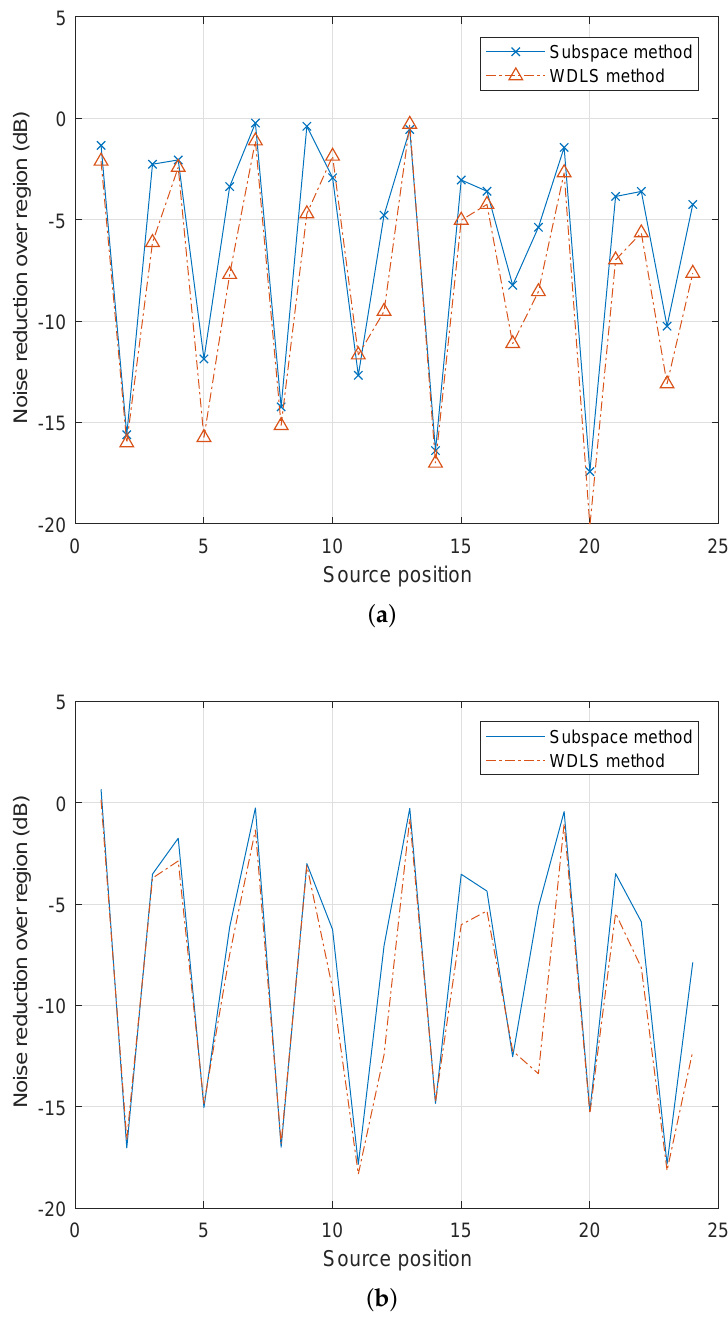
Figure 8. Noise reduction over the region using different loudspeaker setups, when the noise field generated by one primary source moving around the sphere using different methods: ( a ) case 3; ( b ) case